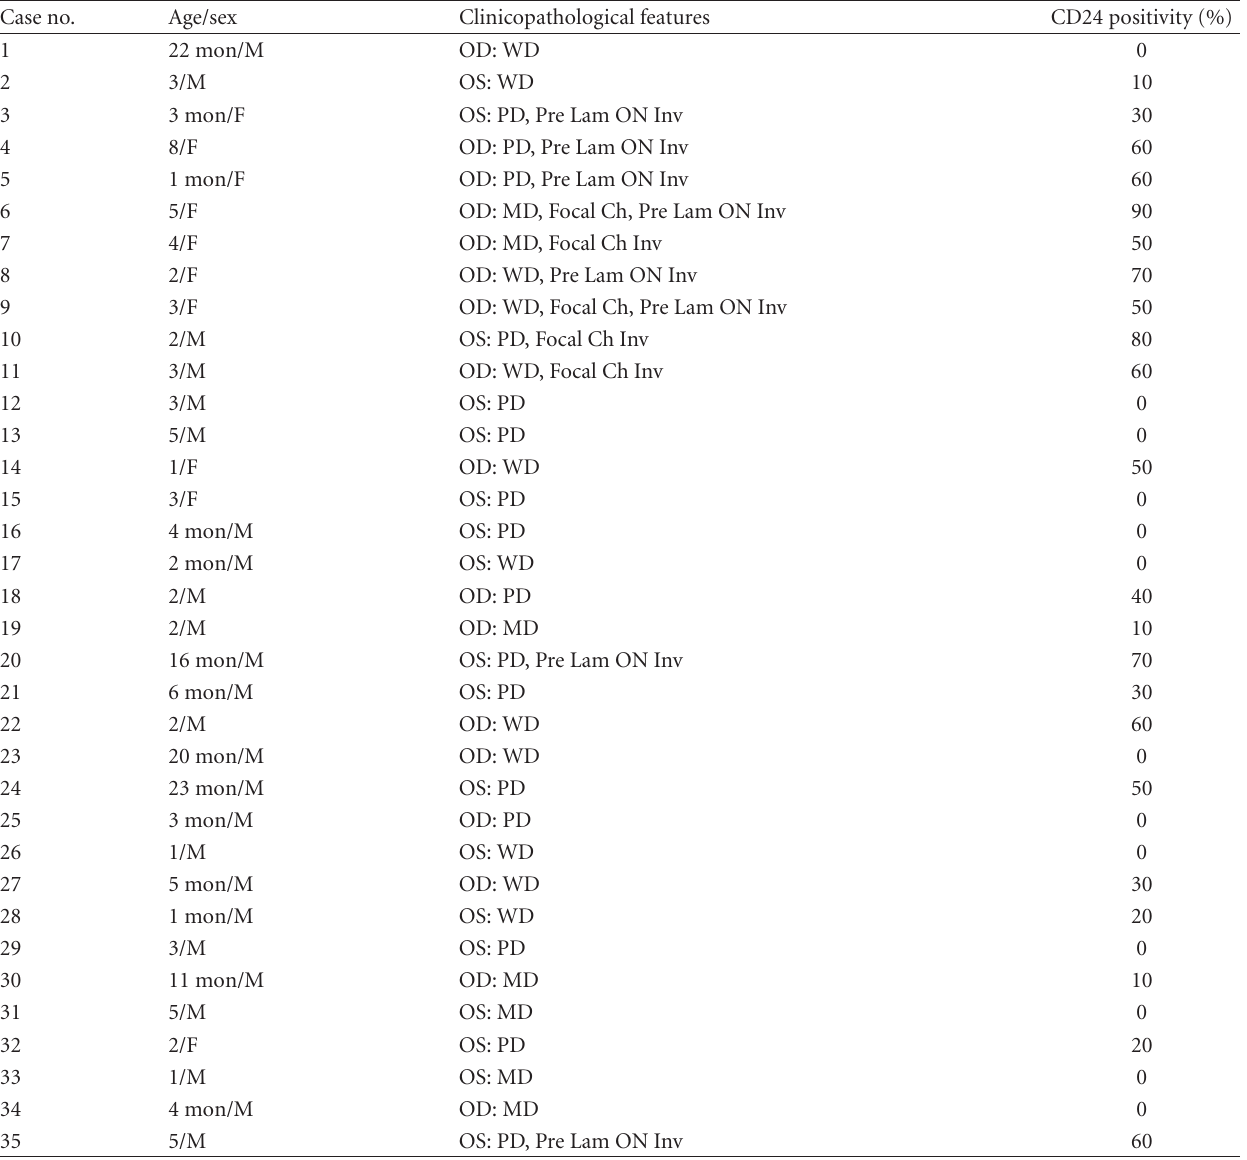
Table 3: The expression of CD24 protein and clinicopathological features of retinoblastoma tissues with low risk of extraocular relapse. Case